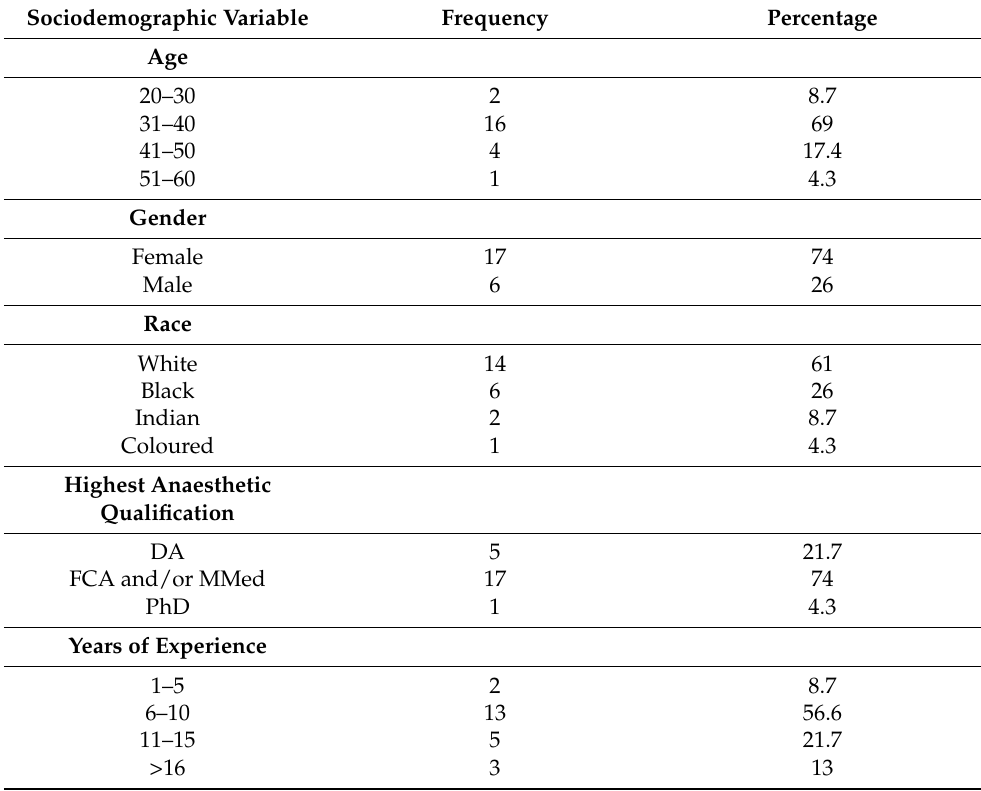
Table 1. Socioeconomic demographics of participants (n =